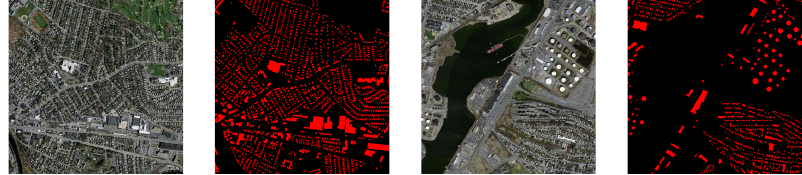
Figure 4. Examples and their ground truth of the Massachusetts dataset. Left: Image, Right: Ground